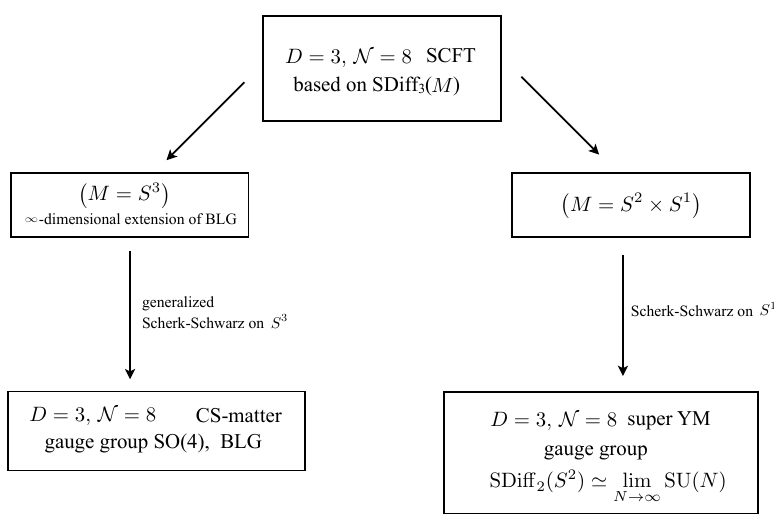
Figure 1 . Web of various